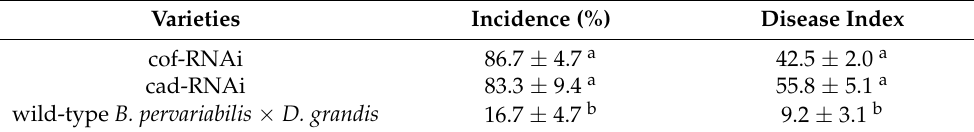
Varieties Incidence (%) Disease Index cof-RNAi cad-RNAi wild-type B. pervariabilis × D. grandis